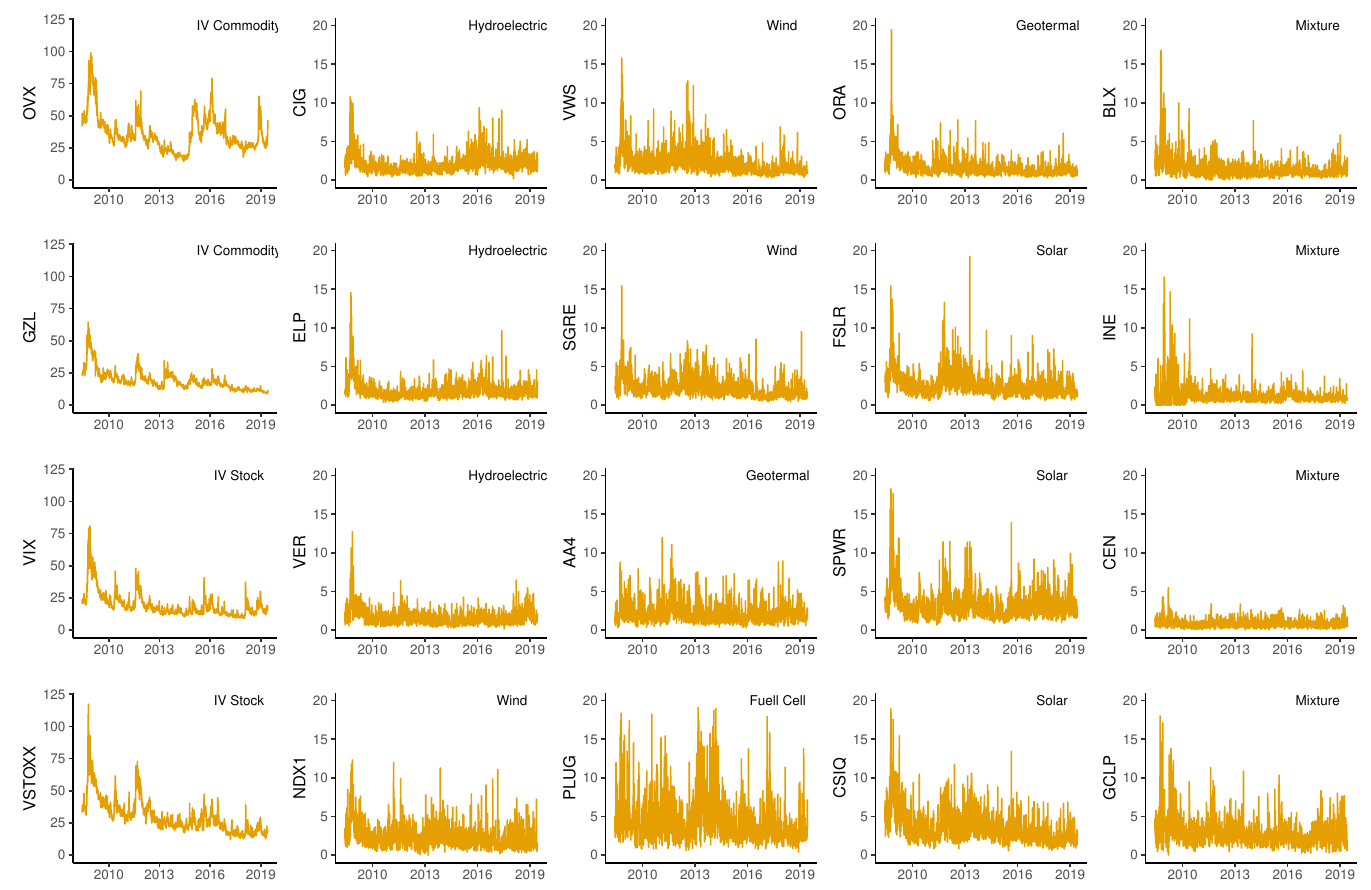
Figure 1. Daily implied volatility time-series (IV of commodities and stocks) and the daily realized volatility time-series for 16 clean energy stocks belonging to the SPGCE (highlighting the sector of production) of each company over the full sample period extending from June 2008 to June 2019. The labels utilized for the description of the companies are detailed in Table